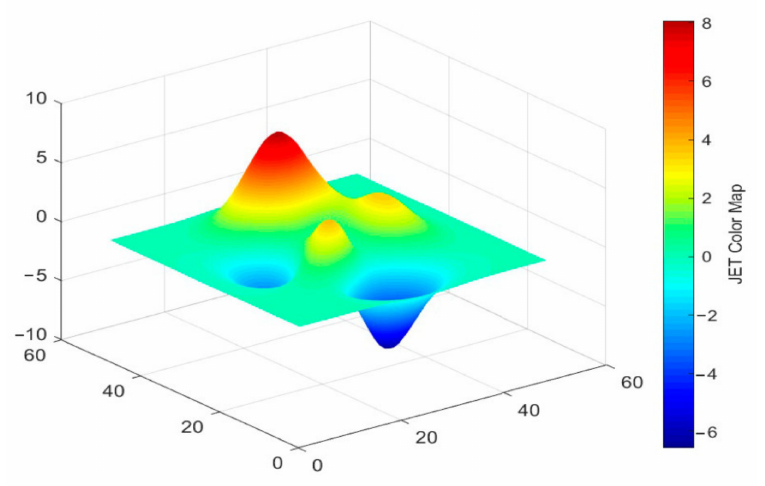
Figure 6. Jet colors generation